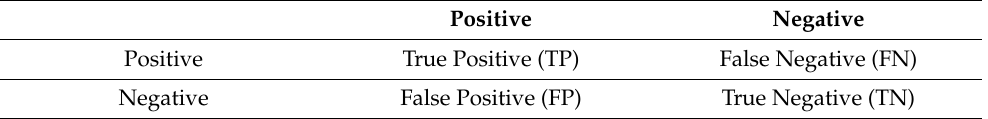
Table 3. Characteristics of a confusion